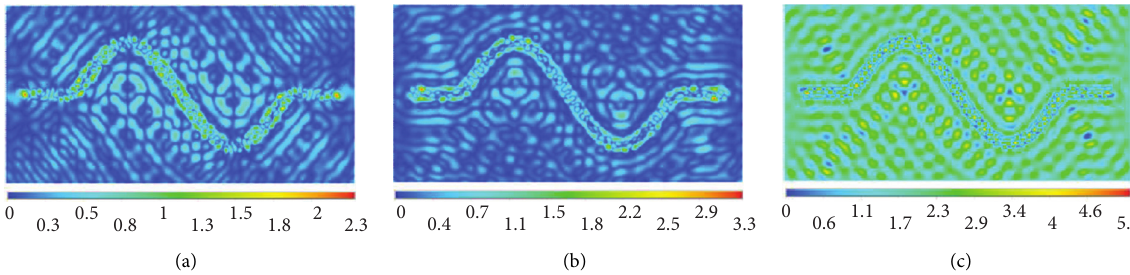
Figure 22: P wave incident ( f � 5.0Hz, H � 100m, C